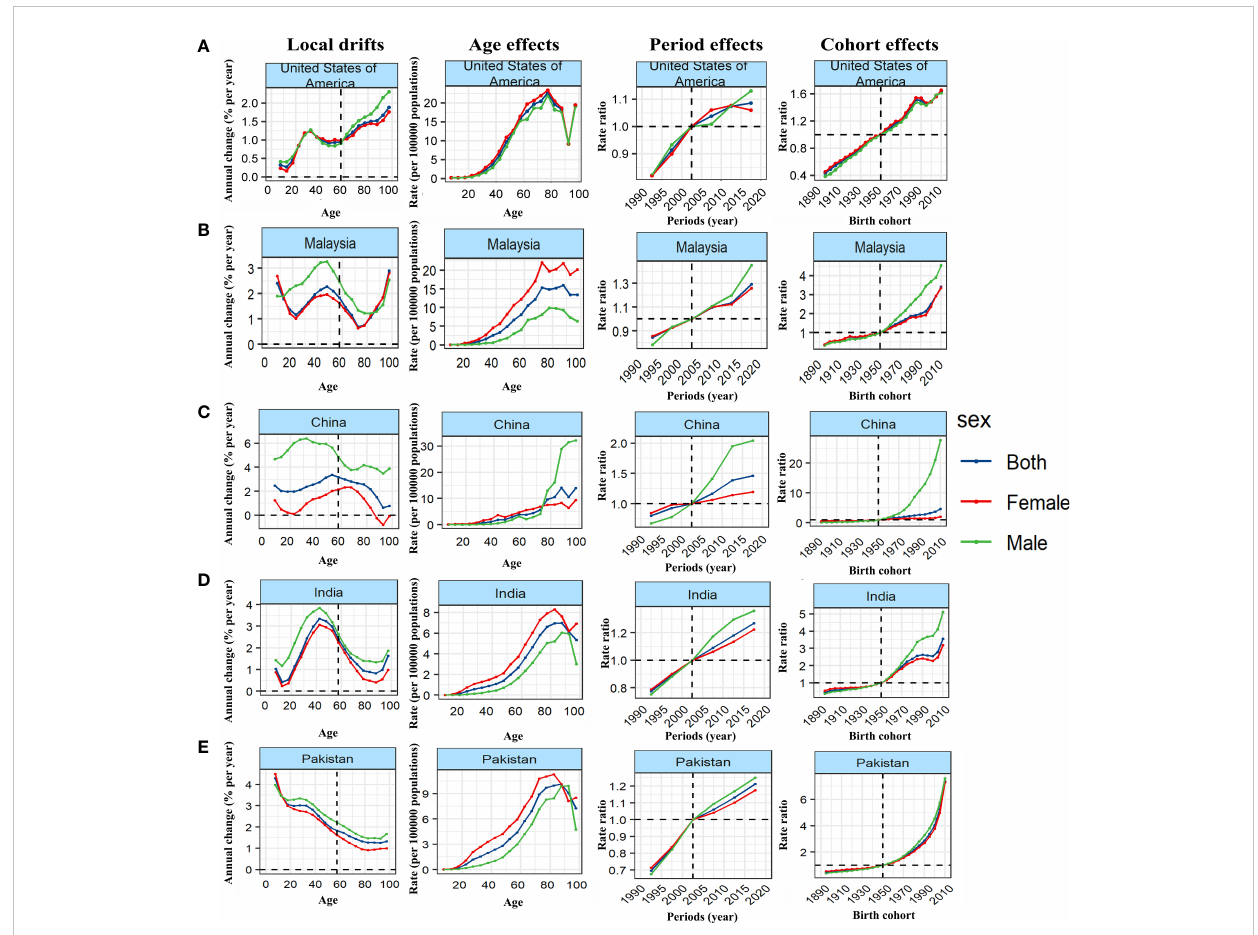
FIGURE 4 Unfavourable APC effects on exemplar countries across (A) high-, (B) high-middle, (C) middle, (D) middle-low and (E) low-SDI countries. Local drifts indicate the annual percentage change of incidence (% per year) across fi ve-year age groups (from 5 to 9 to 95 plus years). Age effects are represented by the fi tted longitudinal age curves of incidence (per 100,000 person-years) adjusted for period deviations. Period effects are represented by the relative risk of incidence (incidence rate ratio) and computed as the ratio of age-speci fi c rates in each period compared to the referent period. Cohort effects are represented by the relative risk of incidence (incidence rate ratio) and computed as the ratio of age-speci fi c rates in each cohort compared to referent 1950